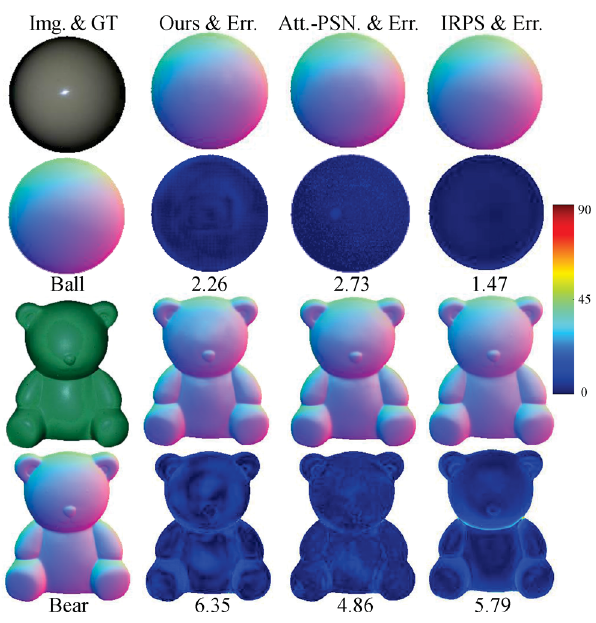
Fig. 4 Quantitative results on Ball and Bear from the DiLiGenT benchmark. Contrast is adjusted for ease of viewing.